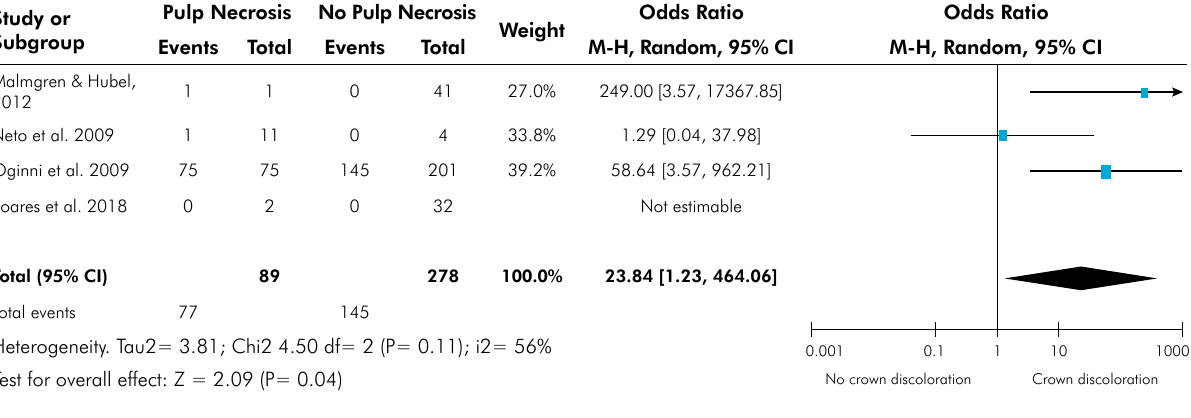
Figure 2. Forest plot the association between pulp necrosis and crown discoloration in traumatized permanent teeth.